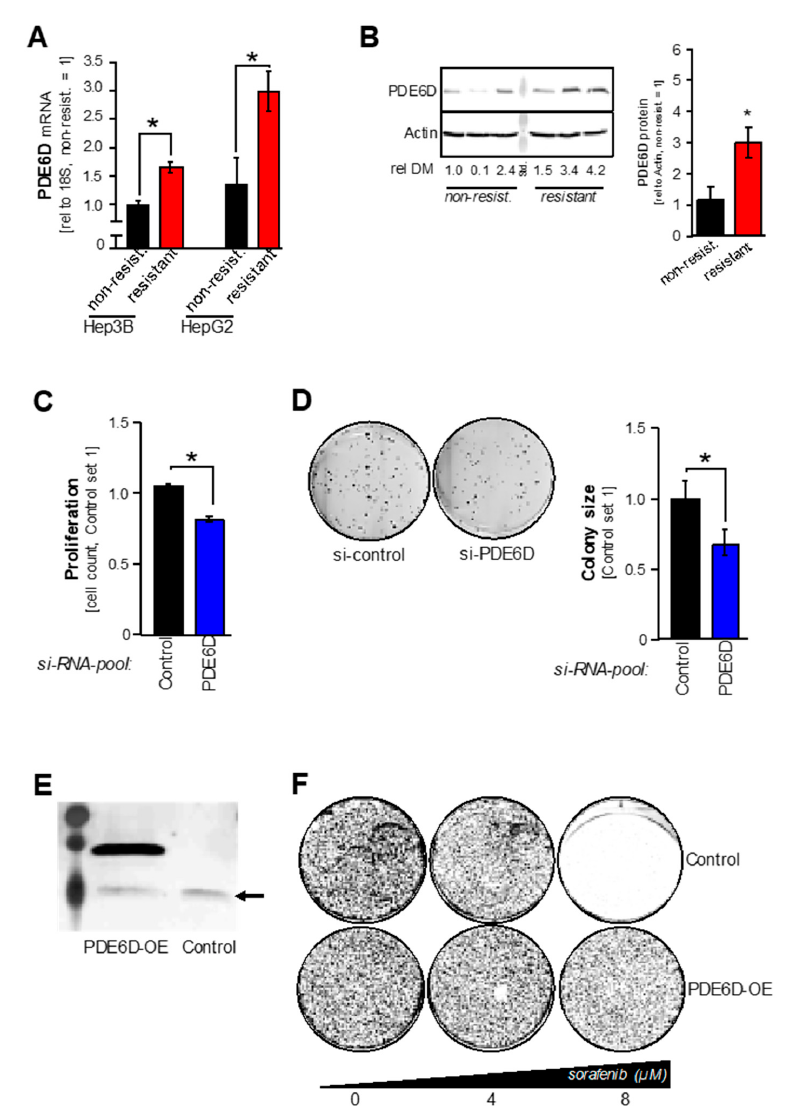
Figure 4. Expression and function of PDE6D in sorafenib resistance. ( A ) PDE6D mRNA levels as quantified by qRT-PCR analysis in non-resistant (“non-resist.”) as compared to sorafenib-resistant (“resistant”) Hep3B and HepG2 cell clones (* p < 0.05). ( B ) Exemplary image (left panel) and summarized densitometric quantification (right panel) of Western blot analysis of PDE6D levels in non-resistant (“non-resist.”) as compared to sorafenib-resistant (“resistant”) Hep3B cells (rel DM: relative (PDE6D/Actin) densitometry) (* p < 0.05 vs. non-resist.). ( C , D ) Prior to functional experiments, resistant cells (Hep3B) were transfected with si-RNA-pools against PDE6D (“PDE6D”) or the according control- si-RNA-pool (“Control”). ( C ) Depicts relative proliferation (cell numbers) and ( D ) depicts exemplary clonogenic assays. ( E , F ) Forced overexpression of PDE6D protein (PDE6D-OE) in HCC cells (e.g., PLC) was performed by transfection of a human PDE6D open reading frame (ORF) Myc-DDK-tagged plasmid vector (an empty control vector without the PDE6D ORF was used as control treatment). ( E ) Depicts Western blot analysis depicting the overexpressed Myc-DDK-tagged PDE6D protein after PDE6D-OE as well as endogenous (arrow) PDE6D in both PDE6D-OE and control-treated cells. ( F ) Depicts exemplary images (representing 8 replicate values of 2 independent experiments) of cells cultured in 6-wells for 72 h (100,000 cells were initially seeded per 6-well) and treated with different doses of sorafenib (0, 4, 8 µ